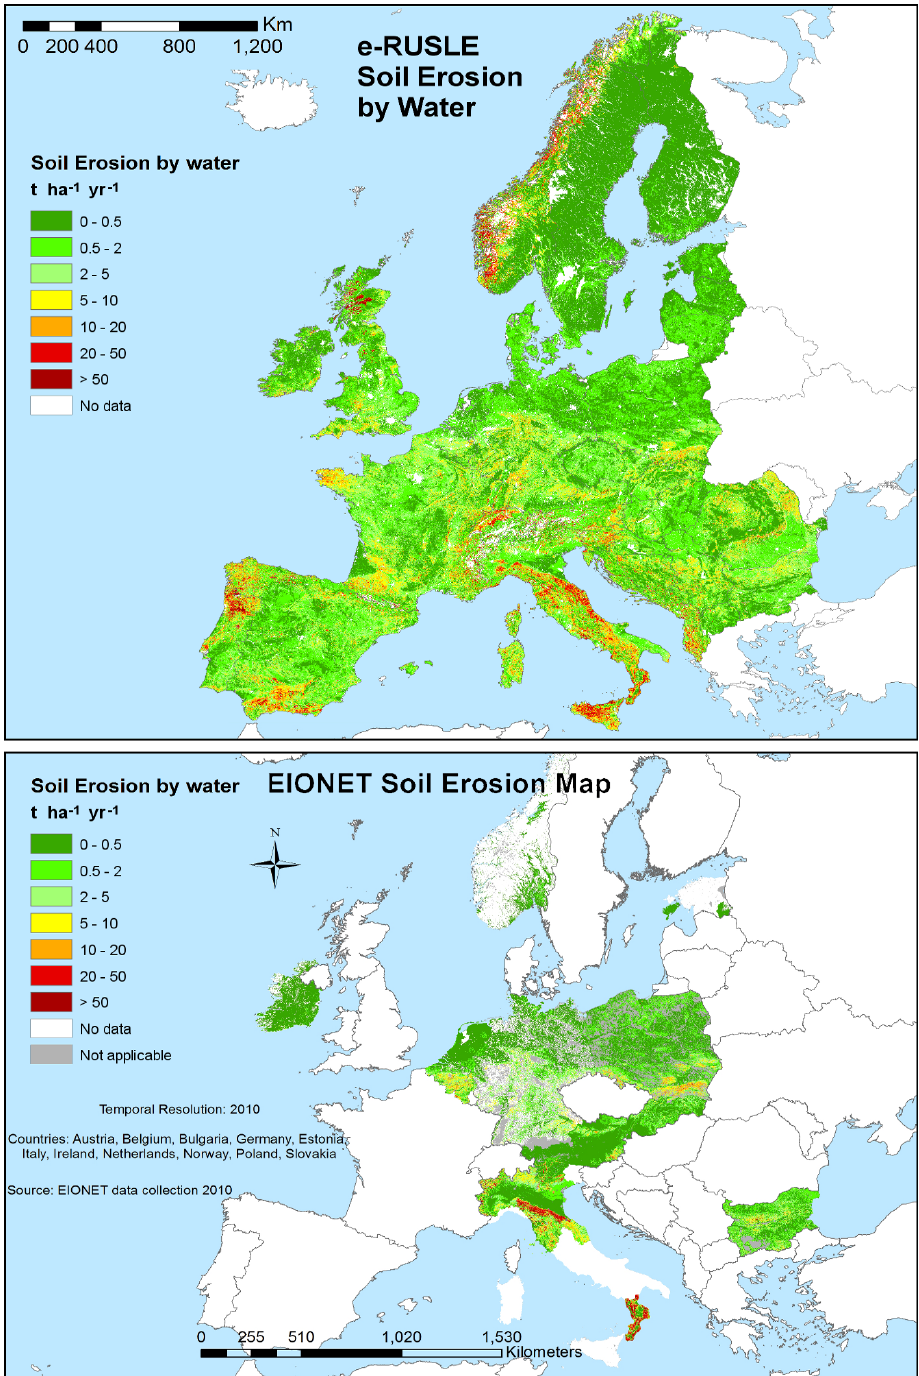
Figure 4. Top: average soil erosion rate by water (2006) as estimated with the e-RUSLE model. Bottom: corresponding EIONET estimates (Panagos et al.,